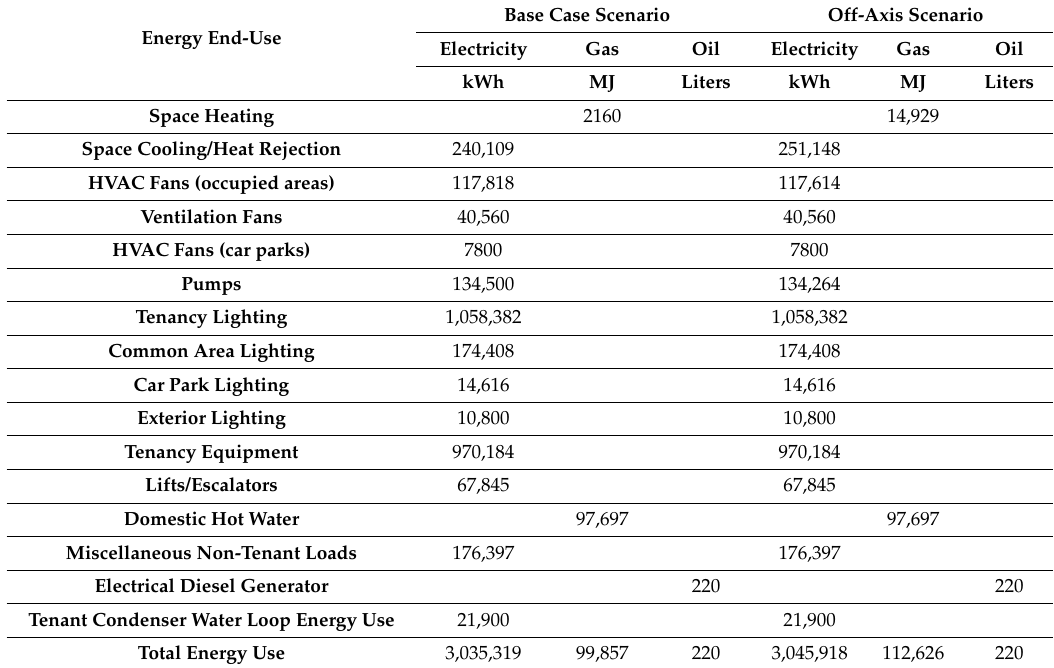
Table 6. Total energy end-use